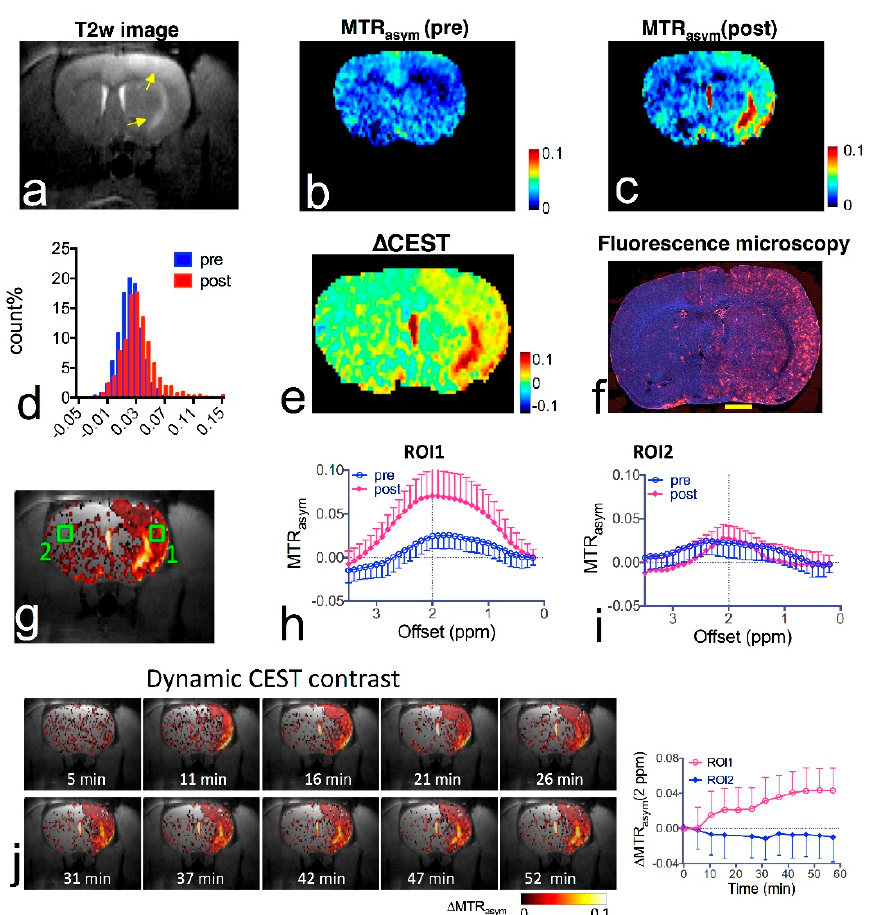
Figure 8. In vivo CEST MRI detection of the delivery of citicoline- liposomes in rat brain after acute ischemic injury. ( a ) T 2 w MRI showing hyperintensity in the injured areas. ( b ) CEST images (MTR asym maps at 2.0 ppm) before and ( c ) at 1.5 h after i.a. injection of CDPC-lipo, showing the elevated CEST contrast in the ischemic region. ( d ) Histogram of the CEST contrast before and after administration. ( e ) ∆ CEST map as calculated by ∆ MTR asym = MTR asym (post) − MTR asym (pre). ( f ) Fluorescent microscopy of nuclei (blue, stained with DAPI) and liposomes (red, rhodamine-B-labeled). Scale bar = 2 mm. ( g ) Overlay image of the ∆ CEST map and the T 2 w image with the two ROIs chosen for ROI analysis. ( h ) MTR asym plots before (blue) and ( i ) at 1.5 h after (red) i.a. injection of CDPC-lipo for ROI 1 and ROI 2, respectively. ( j ) The dynamic CEST contrast change of the stroke within the first 1.5 h after i.a. injection of CDPC-lipo. Left: dynamic CEST images calculated by The dynamic CEST contrast was quantified by Δ MTR asym (t) = MTR asym (t) − MTR asym (t = 0); Right: the mean ROI CEST contrast change of the two ROIs shown in g, where data are presented as mean ± standard deviation. Reprinted with permission from Ref [58].